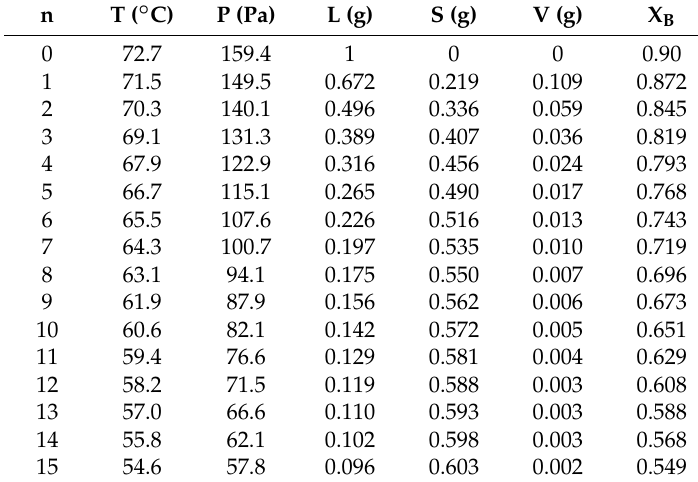
Table 2. The thermodynamic calculations for 1 g feed with X B,0 = 0.90 ( ∆ T = 1.2 ◦ C). n T ( ◦ C) P